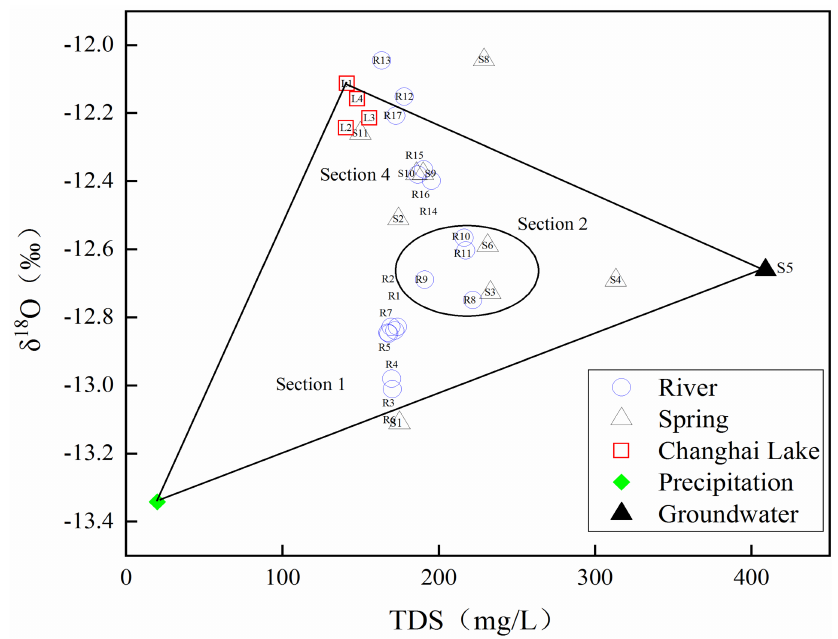
Figure 10. The average values of δ 18 O and TDS of three end-members that form a triangle.